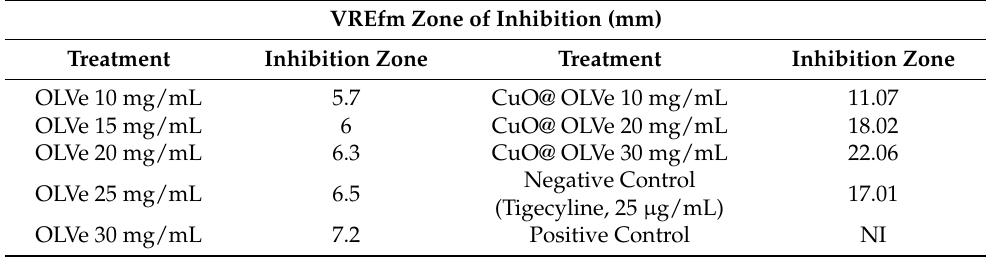
Table 1. Zone of inhibition (mm) plate with diverse concentrations of OVLe and CuO @OVLe NCs. VREfm Zone of Inhibition (mm) Treatment Inhibition Zone